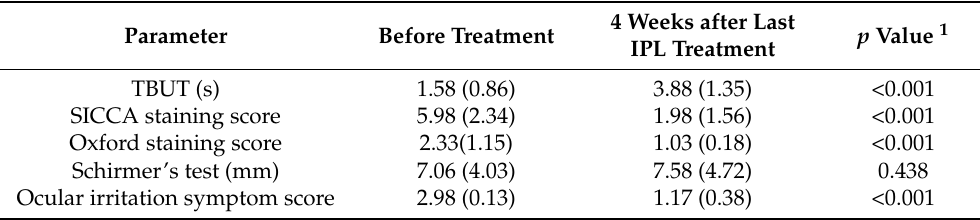
Table 1. Clinical Signs and Symptoms before, and four weeks after, the last treatment of IPL, utilizing a vascular filter in patients with moderate to severe meibomian gland dysfunction. 4 Weeks after Parameter Before Treatment